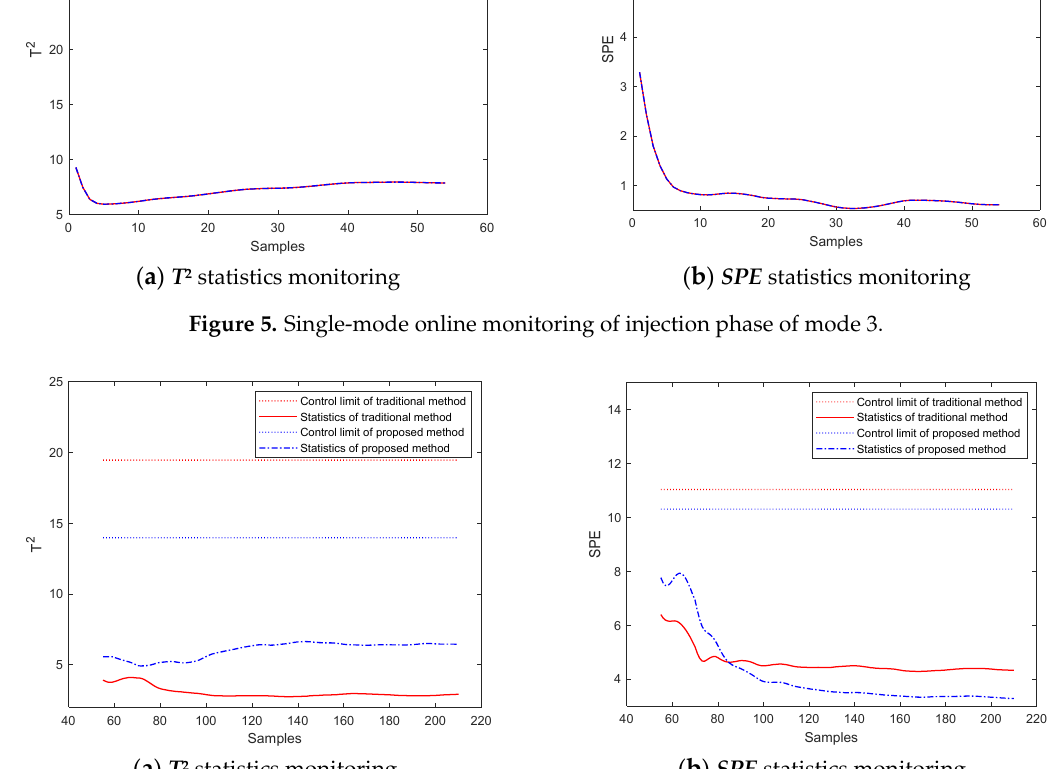
Figure 6. Single-mode online monitoring of packing-holding phase of mode 3.